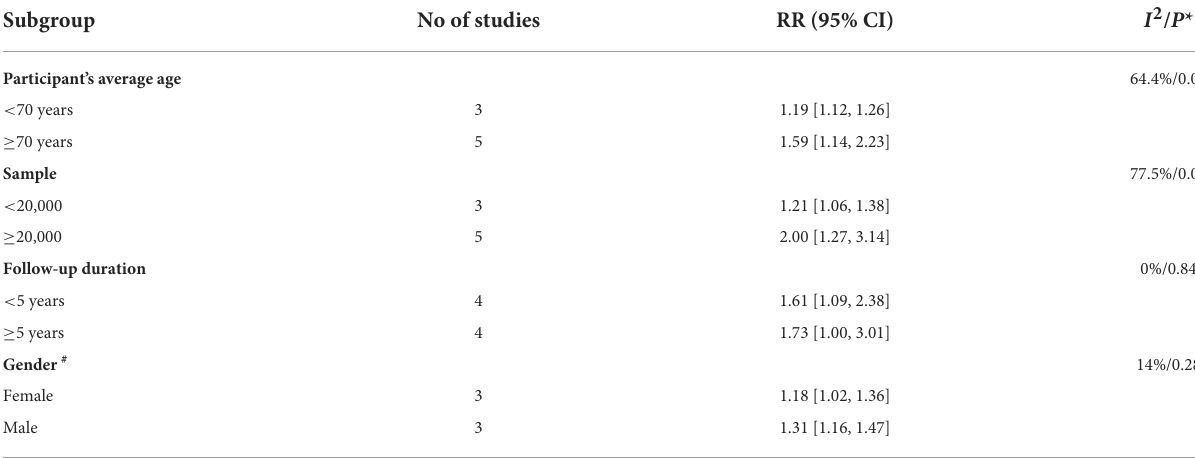
TABLE 2 Subgroup analyses of the association between HF and risk of all fracture.